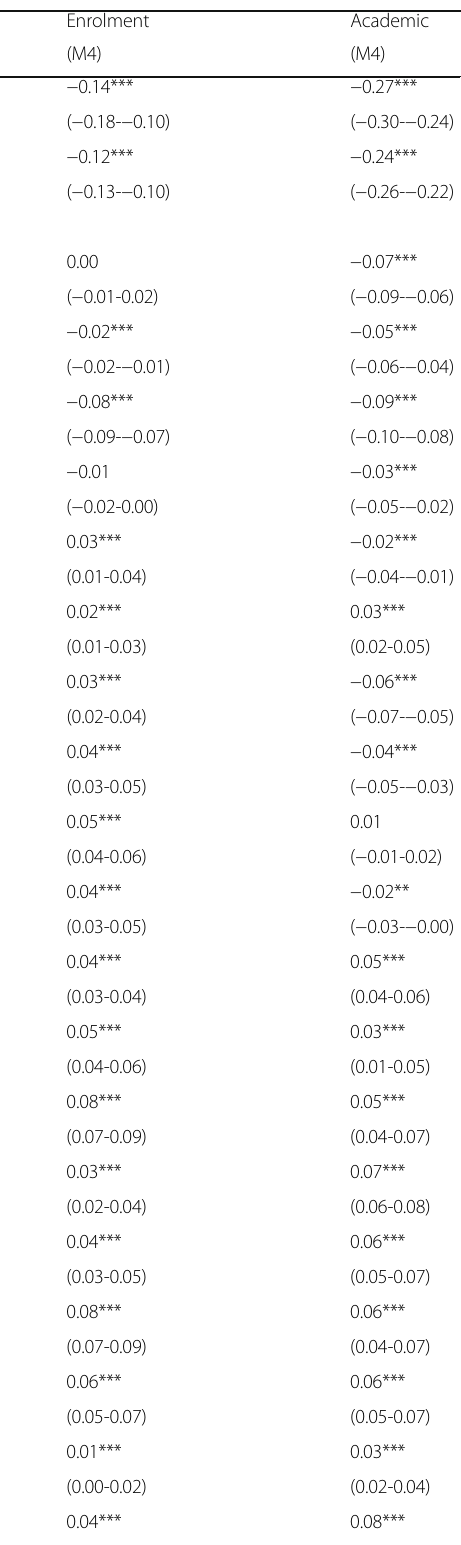
Table 1 Beta coefficients (with 95% c.i.) of control variables from Figs. 1 and 2 (model